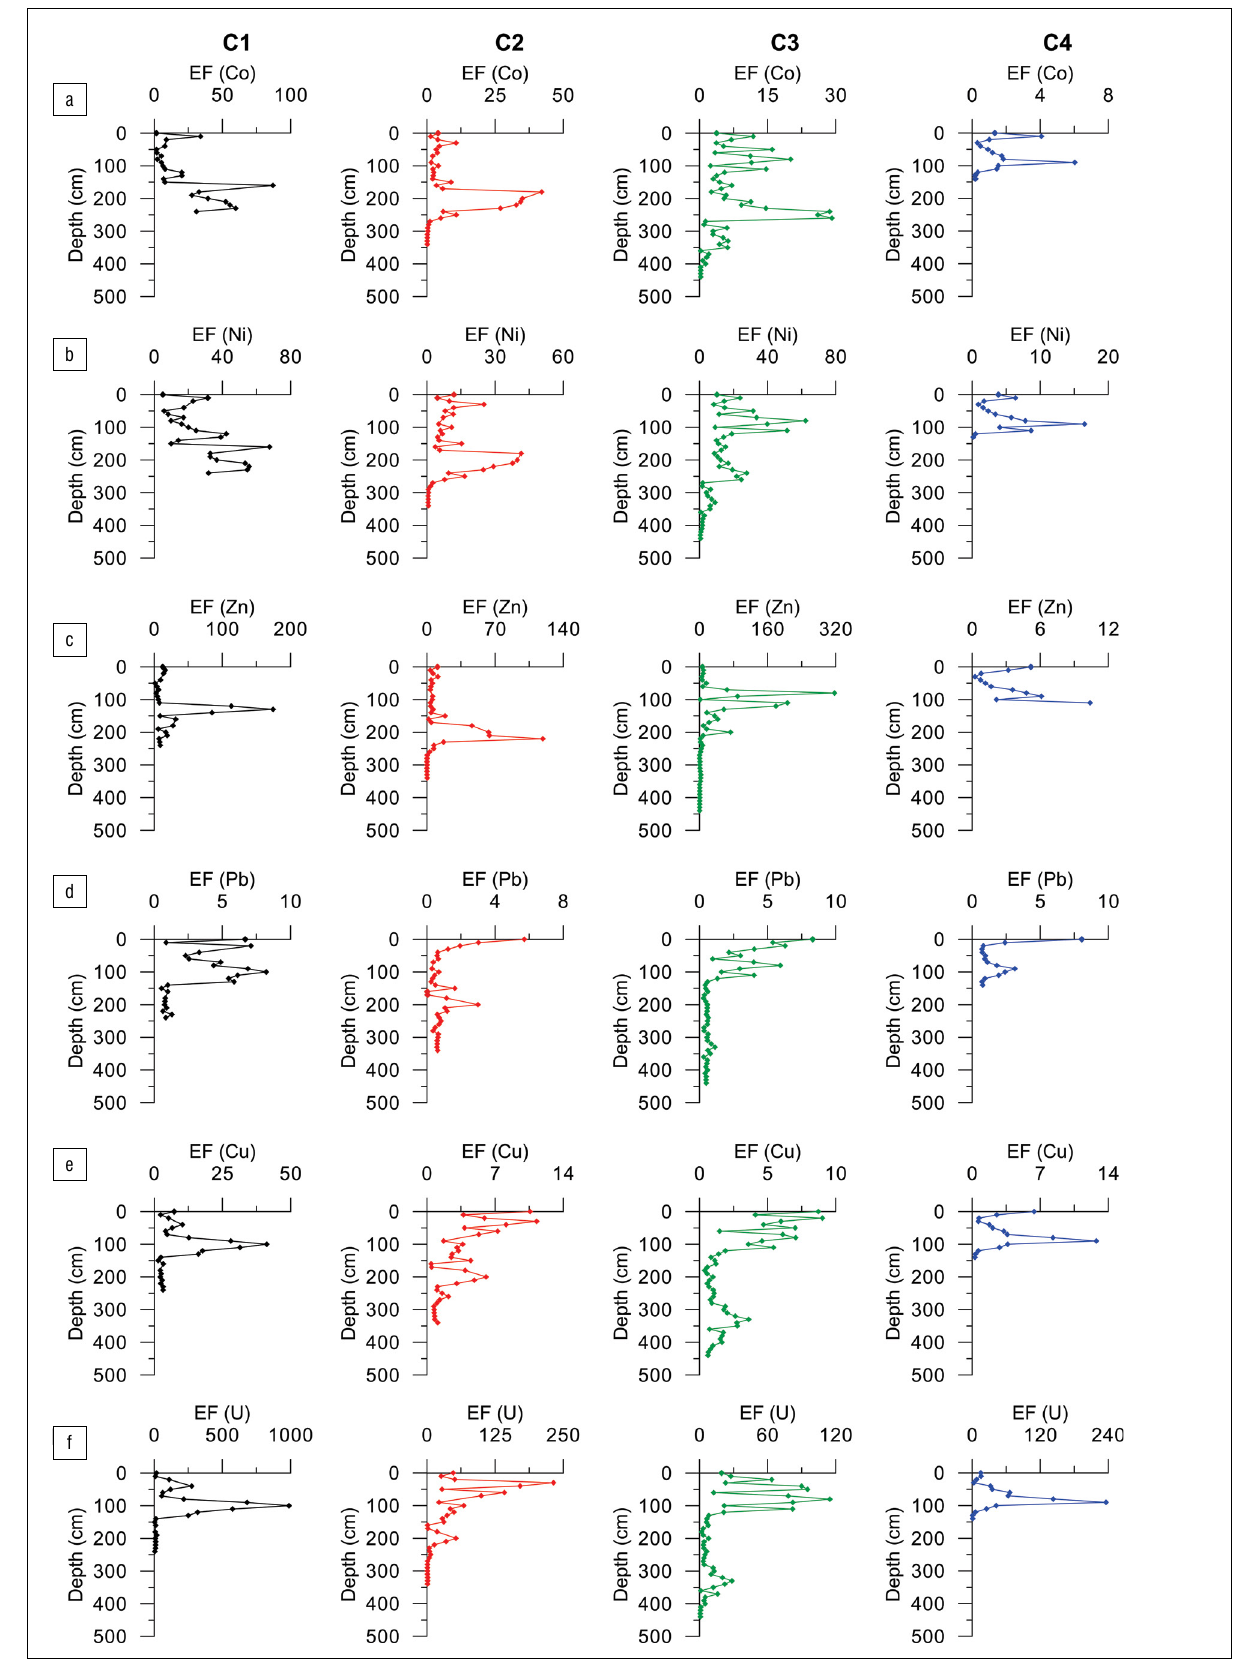
Figure 4: Downcore metal enrichment profiles for sites C1–4. Enrichment factor (EF) values calculated relative to upper continental crust.